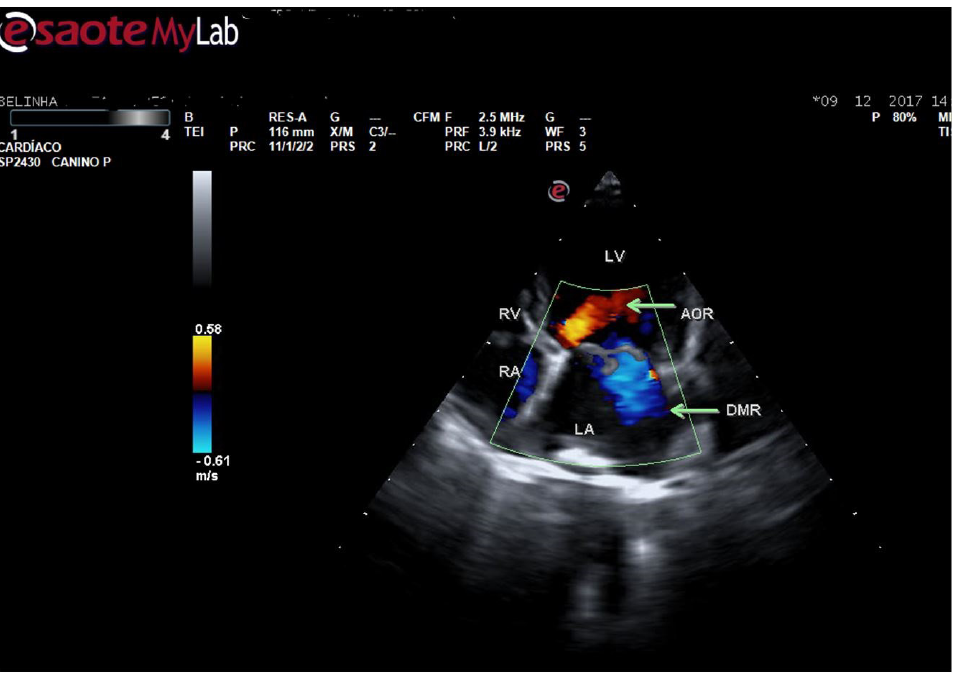
Figure 3. Color flow Doppler mapping (apical 4-chamber view) shows blue color of diastolic mitral reflux (DMR) during 3AVB. LV = left ventricle; RV = right ventricle; RA - right atrio; LA = left atrio; AOR = atrium aorta